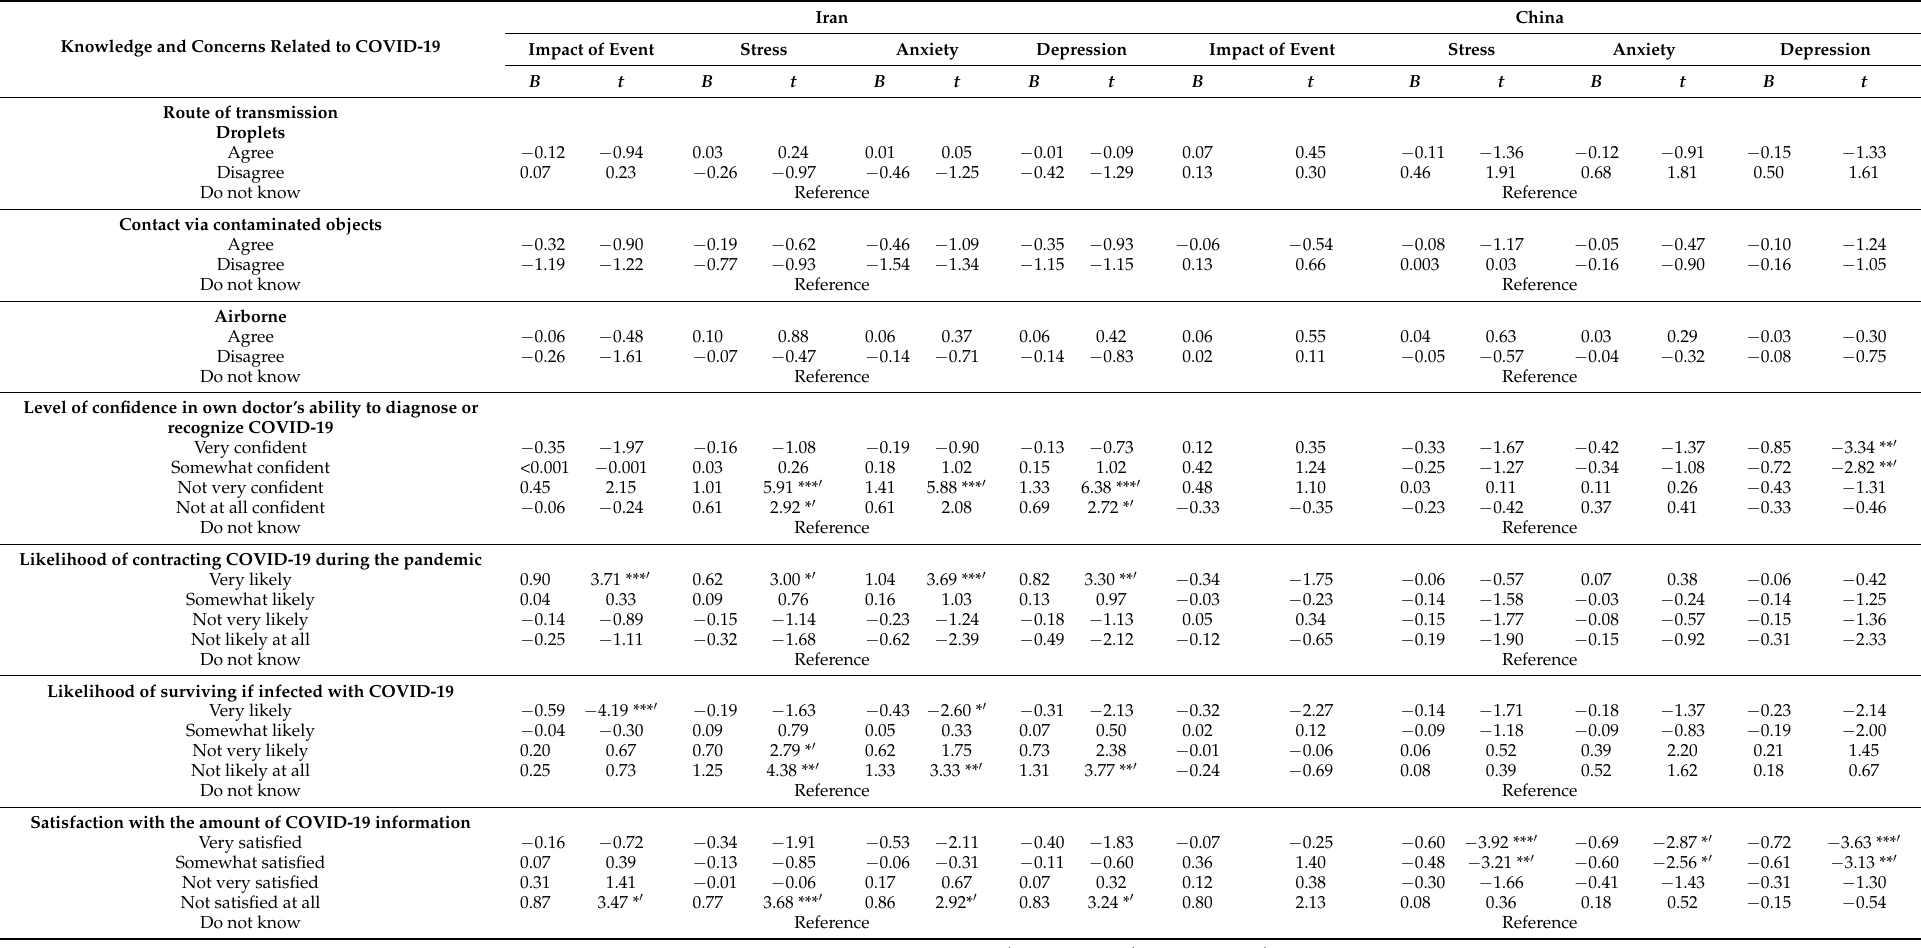
Table 3. The linear regression analysis of knowledge and concerns related to COVID-19 and mental health parameters in Iranian and Chinese respondent ( n = 1411).